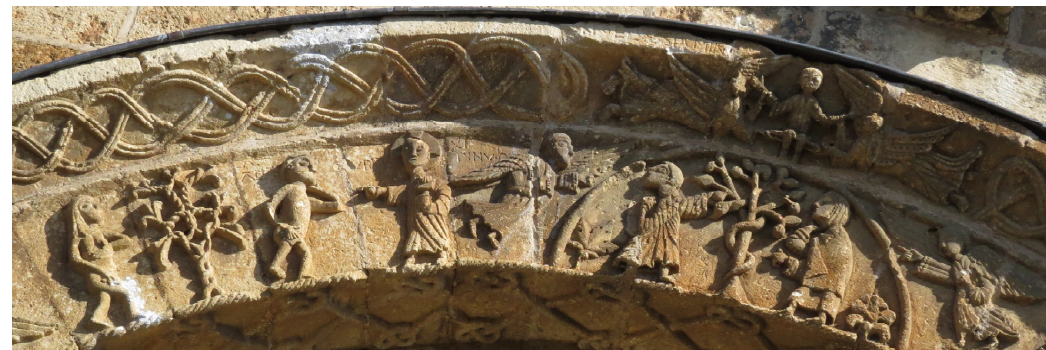
Figure 5. Temptation and Fall of Adam and Eve, detail of archivolt, west façade, Saint-Martin Church , 12th c., Besse, Dordogne, Nouvelle-Aquitaine, France. ©Author.